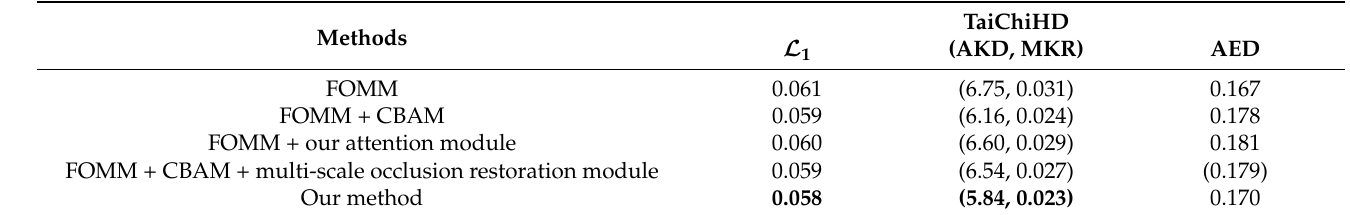
Table 2. Ablation study on the TaiChiHD (256) dataset with 10 keypoints (the best result is displayed in bold).